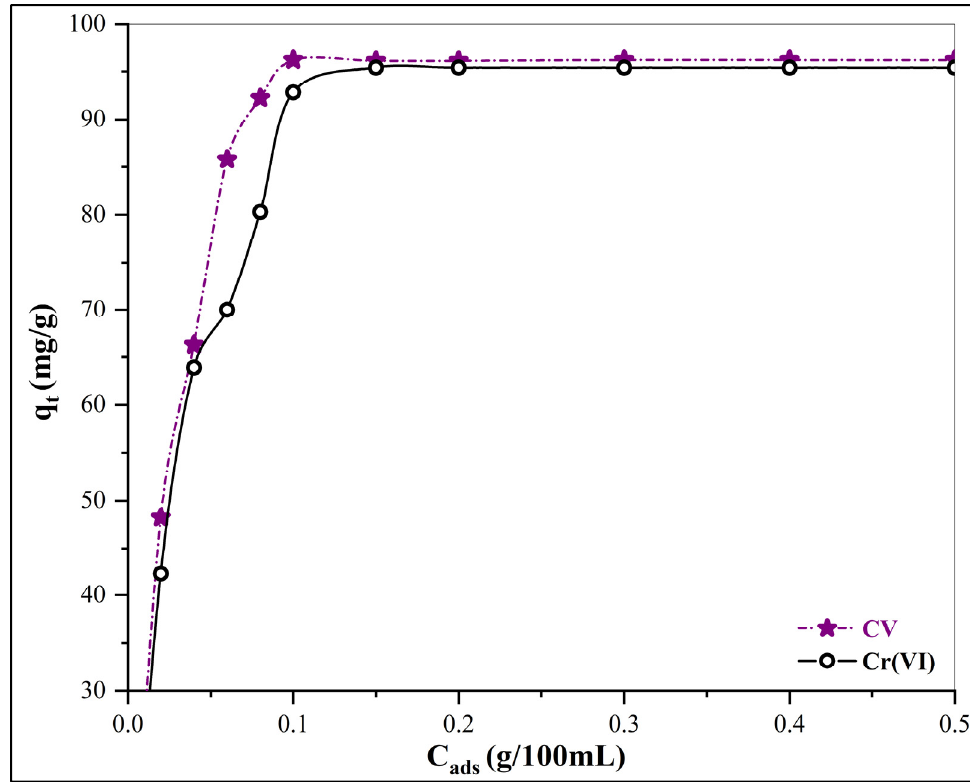
Figure 9. Effect of adsorbent dose on Cr (VI) and CV removal.